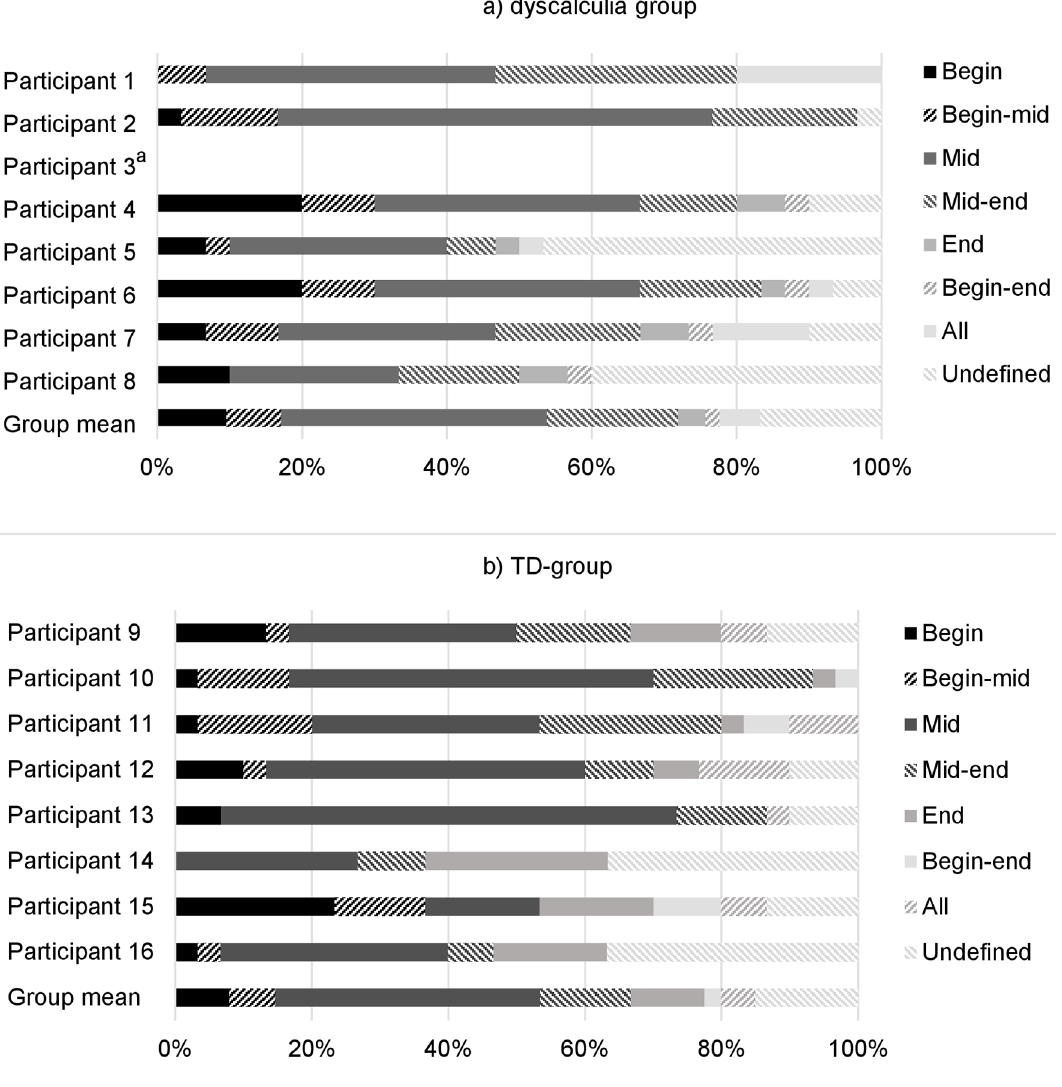
Figure 4. Percentage of reference point (Combinations) used on the bounded NLT per